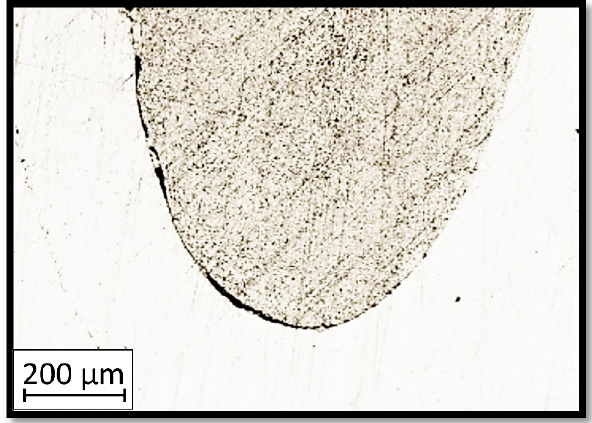
Figure 10. Imperfections (black areas) at the end of the wavy borderline of the joint.